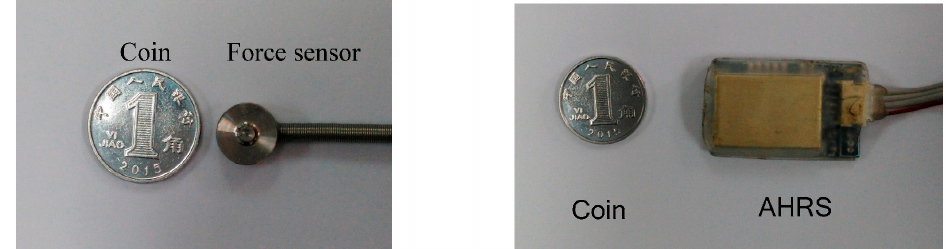
Figure 5. The GRF sensor and the AHRS sensor of the system, which are small and thin to be embedded in the mechanical structure.